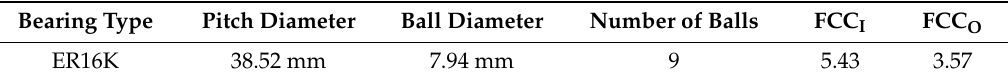
Figure 13. Experimental equipment. Table 2. Parameters of rolling bearing.